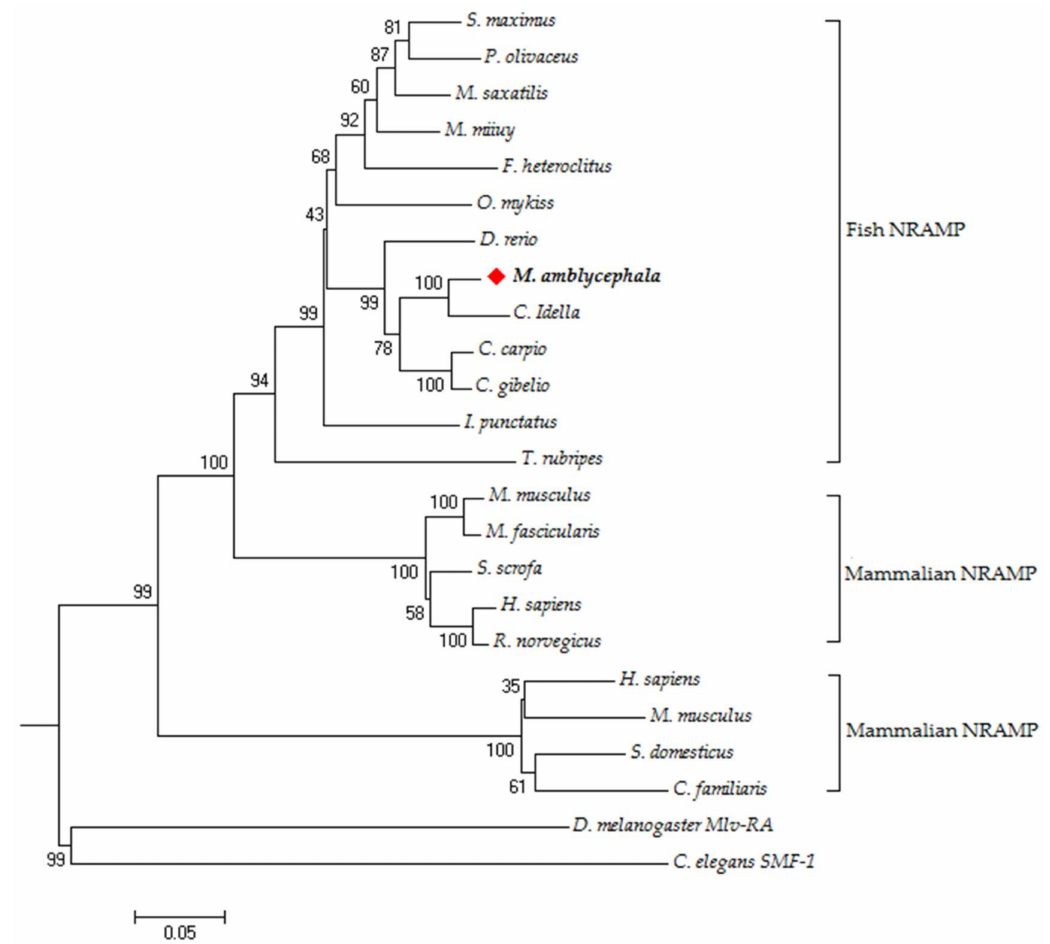
Figure 2. The phylogenetic tree of NRAMPs protein was constructed by neighbor-joining method. The numbers at the nodes represent the bootstrap values for 1000 replications and the genetic distance is shown by the bar (0.05). All NRAMPs protein sequences were obtained from GenBank